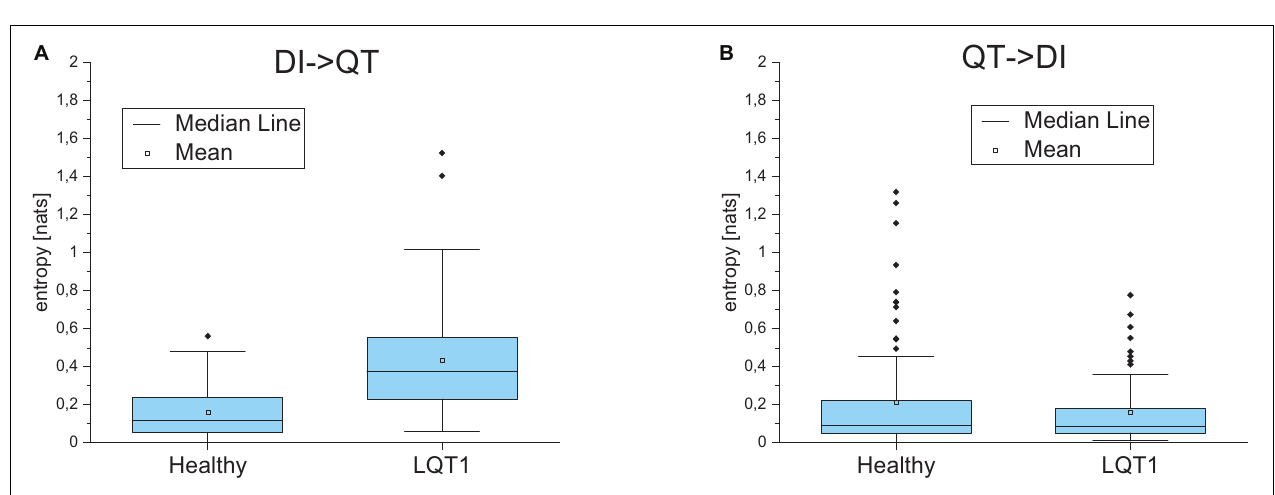
FIGURE 6 | (A) Transfer entropy from the diastolic intervals to the QT intervals and in the opposite direction (B) for healthy individuals and for LQTS1 patients. p -Values: DI- > QT: 1.60104E-9, QT- > RR: 0.94574.